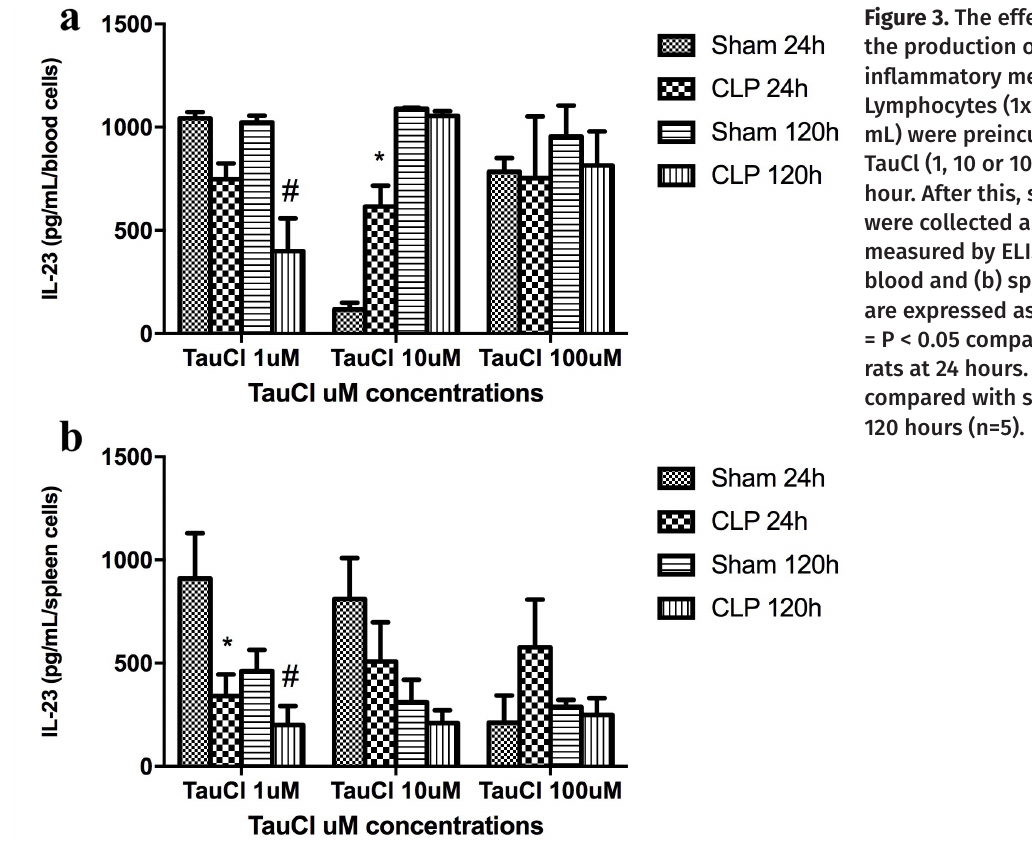
Figure 3. The effect of TauCl on the production of the pro- inflammatory mediator, IL-23. Lymphocytes (1x106 cells/ mL) were preincubated with TauCl (1, 10 or 100 uM) for 1 hour. After this, supernatants were collected and IL-23 was measured by ELISA for (a) blood and (b) spleen. Results are expressed as means ± SD. * = P < 0.05 compared with sham rats at 24 hours. # = P < 0.05 compared with sham rats at 120 hours